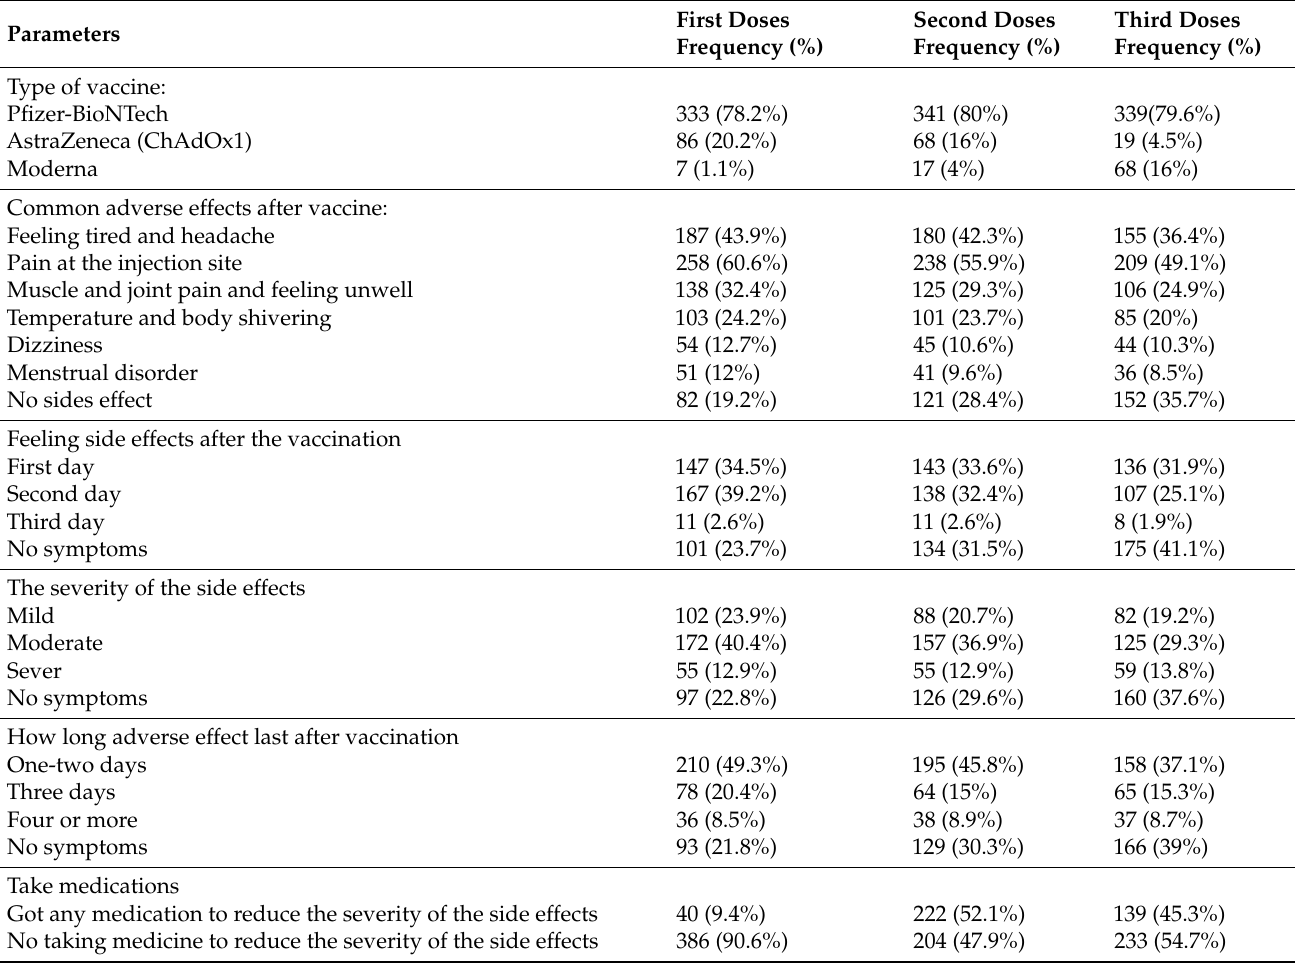
Table 2. Adverse effects of the first, second and third dose of Pfizer, Oxford–AstraZeneca, and Moderna COVID-19 vaccination (n = 426).